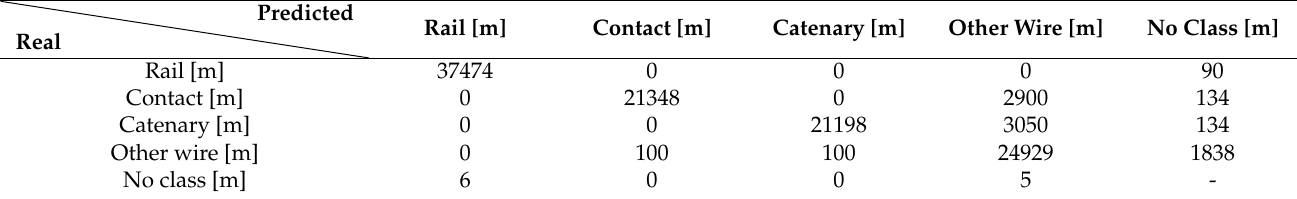
Figure 15. Results of the segmentation method: masts are represented in gold colour. Each contact wire has a different colour, matched by its correspondent rail. Each catenary has also a random colour. Other wires are coloured in pink, droppers in black, and marks in magenta. Table 3. Confusion matrix of continuous elements measured in metres.